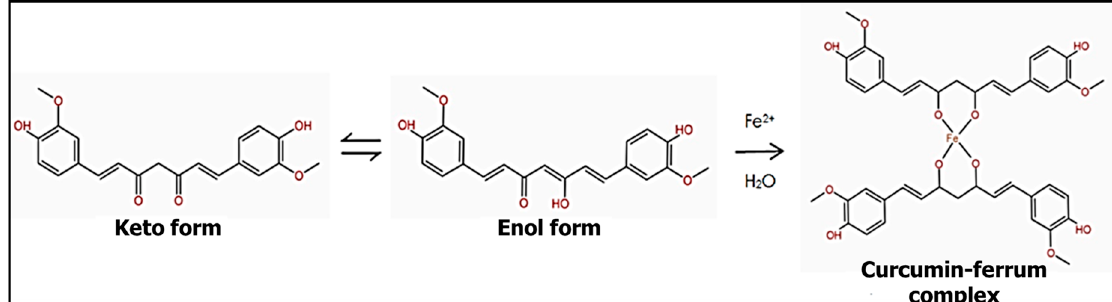
Figure 3. Formation of curcumin/ferrum complex.